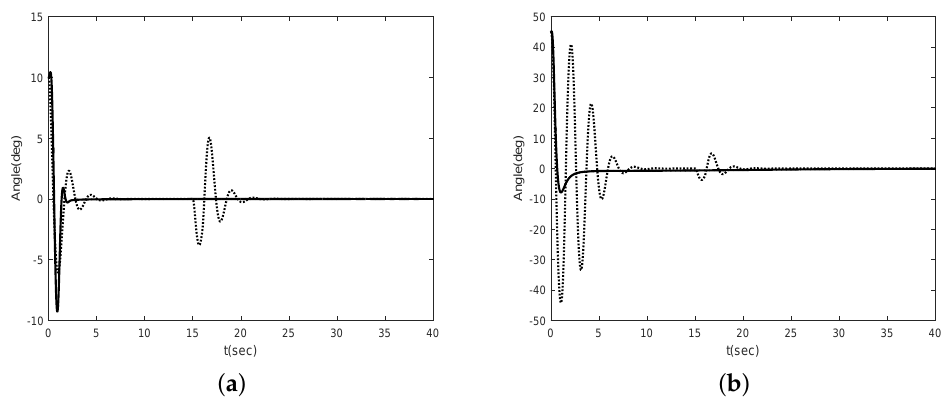
Figure 7. Angle of Segway with disturbance (solid : proposed method, dotted : LQR method): ( a ) θ ( 0 ) = 10 ◦ ; ( b ) θ ( 0 ) = 45 ◦